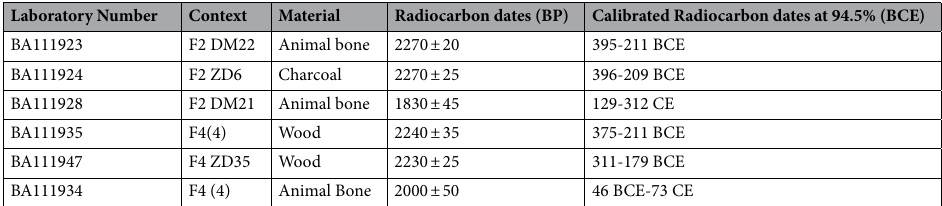
Table 2. Calibrated radiocarbon dates for Shirenzigou F2 and F4. Accelerator Mass Spectrometry Dating Laboratory of Peking University and calibrated using OxCal and IntCal20 51,52 .